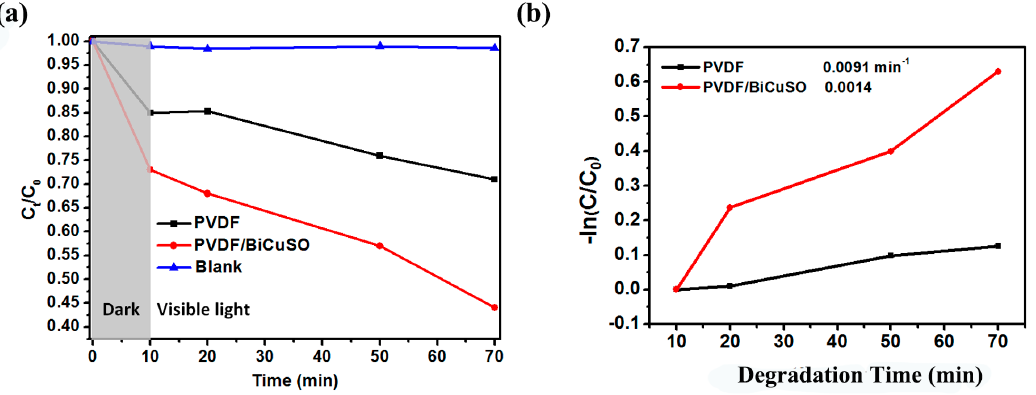
Figure 5. ( a ) Degradation rate of aqueous solution photocatalysis with PVDF and PVDF/BiCuSO as catalysts under visible light in 70 min. ( b ) Kinetic linear simulation curve of Congo Red photocatalytic degradation with as-prepared samples.